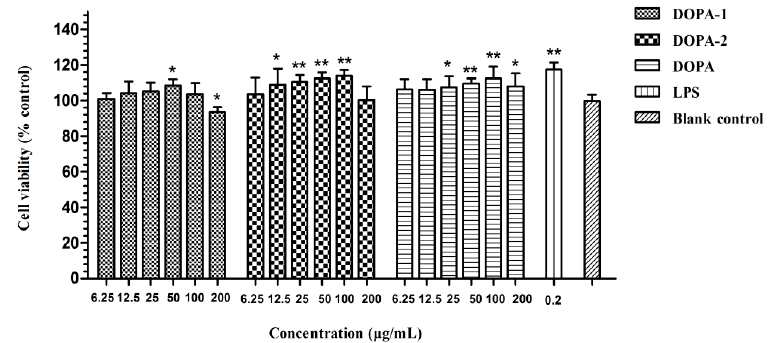
Figure 4. Effects of D. officinale polysaccharides on RAW 264.7 cell viability. The results were shown as means ± SD ( n = 5). * p < 0.05, ** p < 0.01 compared with the blank control.